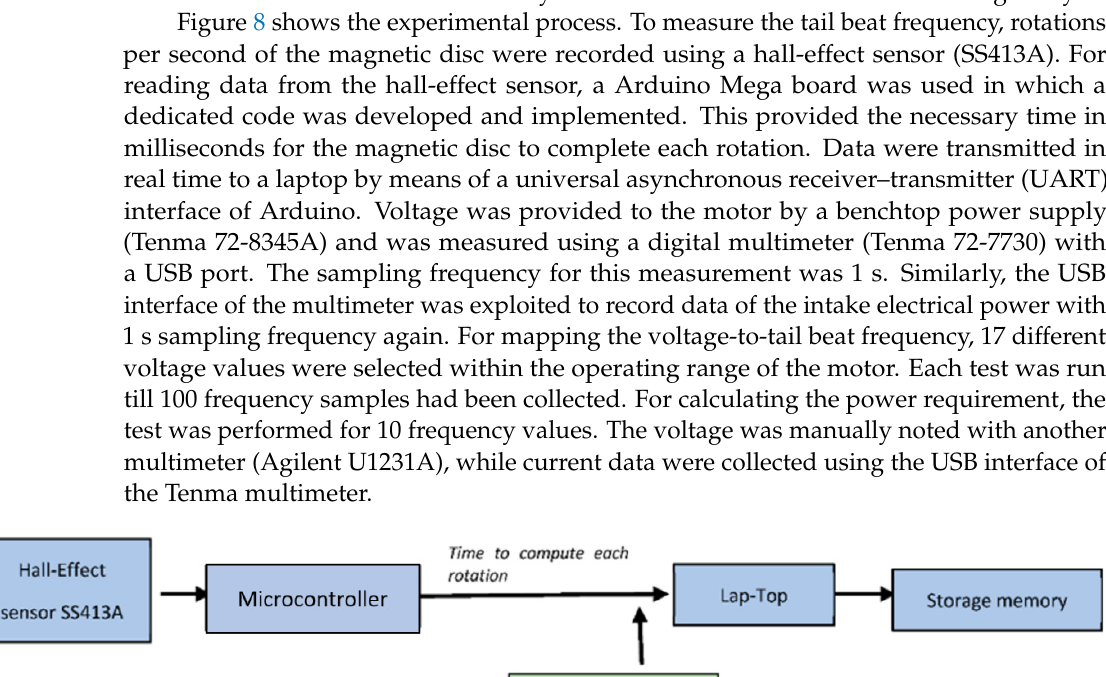
Table 4. List of the motor voltage values and the corresponding values of the tail beat